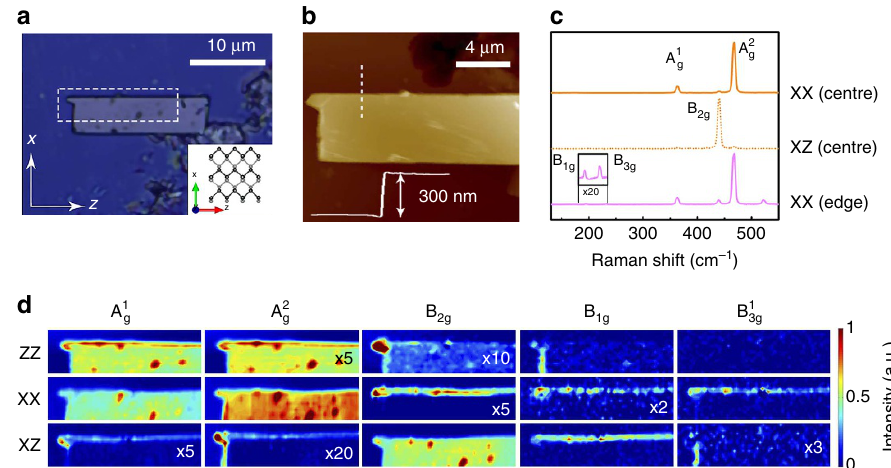
Figure 1 | Characterisation and Raman results of an exfoliated flake of BP with armchair and zigzag edges. ( a ) Optical microscope image of the measured flake; the white dashed rectangle defines the analysed area. The corresponding crystal orientation and crystallographic x and z axes are presented in the inset (Note that we assume the y axis to be perpendicular to the crystal layers). ( b ) Atomic force microscopy image of the measured flake. ( c ) Polarized Raman spectra at the centre of the flake with the XX (top) and XZ (middle) scattering configurations and at an armchair edge (bottom) with the XX configuration, where the first (second) index represents the polarization of the incident (scattered) light. ( d ) Hyperspectral Raman intensity images of all observed modes: A 1 , A 2 , B 2 g , B 1 g and B 1 (columns), for the different scattering configurations indicated on the left side (if the z axis, instead of the y g g 3 g axis, is assumed normal to the layers, the assignment of the B g symmetry modes would vary; in particular, the B 2 g mode would become the B 1 g mode). Band intensities are represented by the colour bar and were normalized to the highest value of each mode. When necessary, for better visualization, the intensity was multiplied by a factor, as indicated at the bottom-right corner of each